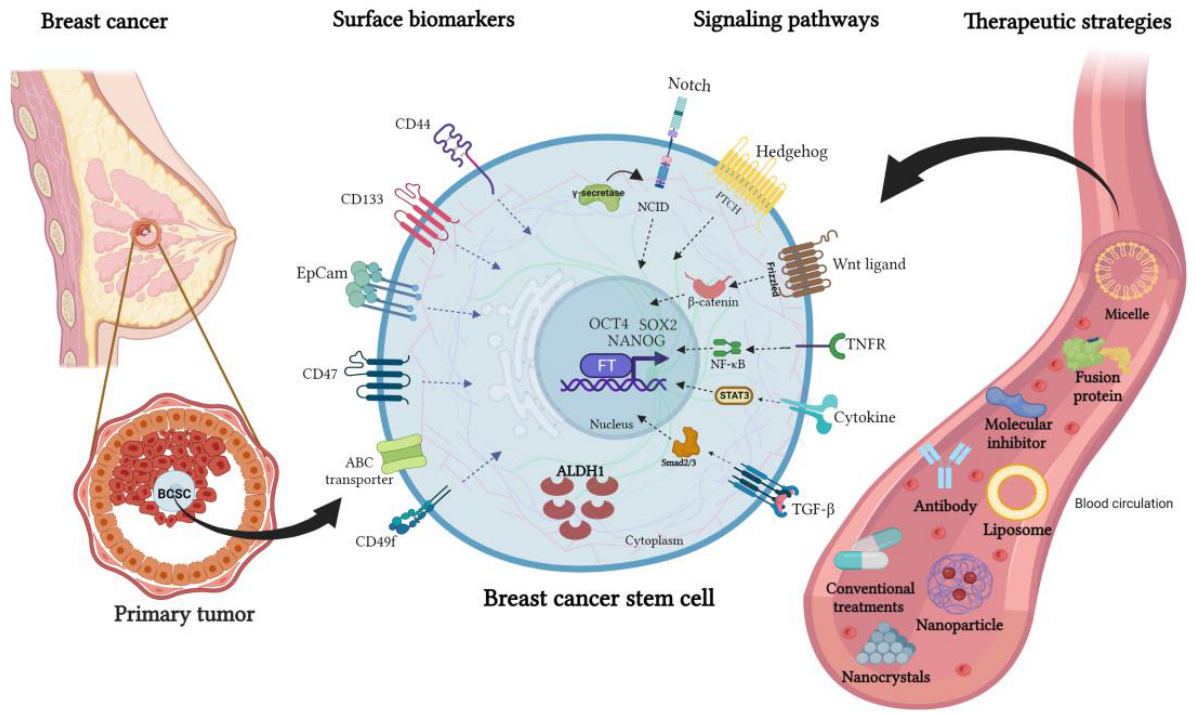
Figure 2. Surface biomarkers, signaling pathways, and an overview of new therapeutic strategies to target breast cancer stem cells. Mammary CSCs express cell surface proteins that are used as biomarkers such as CD133, CD44, EpCAM, CD47, CD49f, and ATP-binding cassette (ABC) transporters. In addition, this cell subpopulation has active signaling pathways, being the main ones Notch, Hedgehog, TGF- β , Wnt/ β -catenin, STAT3, PI3K/AKT, and NF- κ B. The expression of transcription factors (Nanog, SOX2, and OCT4) allows them to acquire and maintain the characteristics of self-renewal, pluripotentiality, tumorigenic capacity, resistance to therapies, and high metastatic capacity. Several therapeutic strategies have been developed to deliver BCSC-targeted drugs, such as liposomes, micelles, nanoparticles, nanocrystals, and antibodies directed against membrane proteins or inhibitors of BCSC-associated signaling